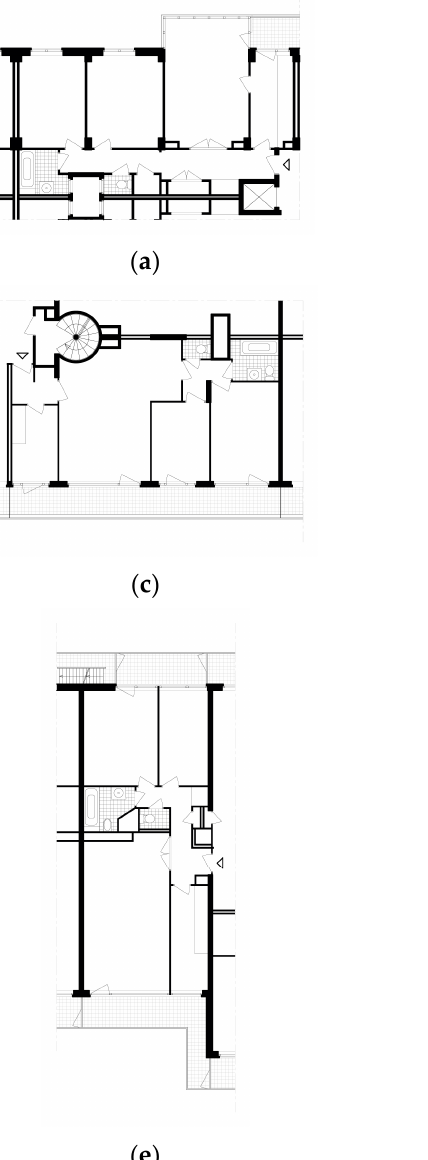
Figure 6. Dwelling plans of selected postwar types (re-drawings by the authors): ( a ) Alexis Dumont and Paul Goolaerts, avenue de la Brabançonne 80 (1954); ( b ) Maxime Brunfaut, avenue Auguste Vermeylen 58–60 (1956); ( c ) Groupe Urbanisme, drève du Château 75–77 (1964); ( d ) Jean-Claude Cahen, rue Théodor De Cuyper 119–123 (1964); ( e ) Jacques Mignolet, quai du Batelage 1–15 (1971); ( f ) M. Boelens and R. Wasterlain, rue Victor Rauter 30–34 (1976).